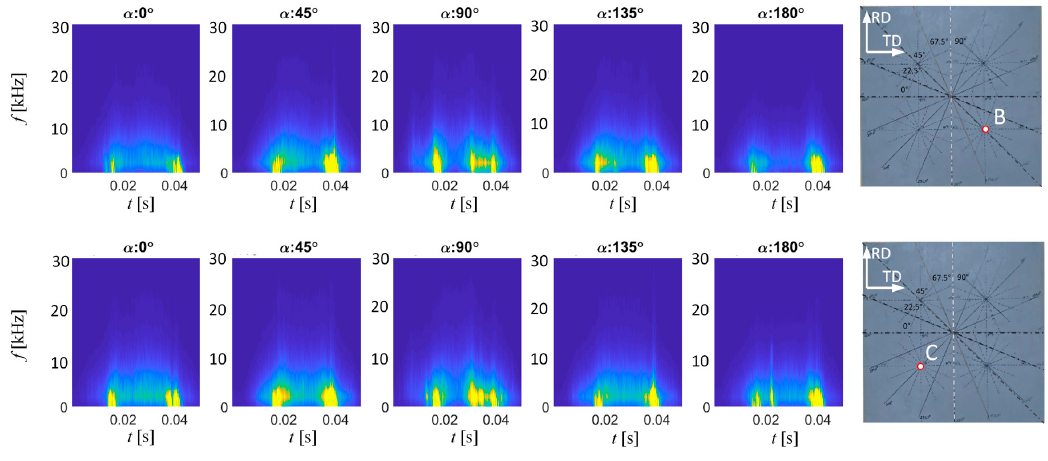
Figure 8. BN TF_S spectrograms distributions obtained for various orientation of the transducer over B and C locations in the sample.